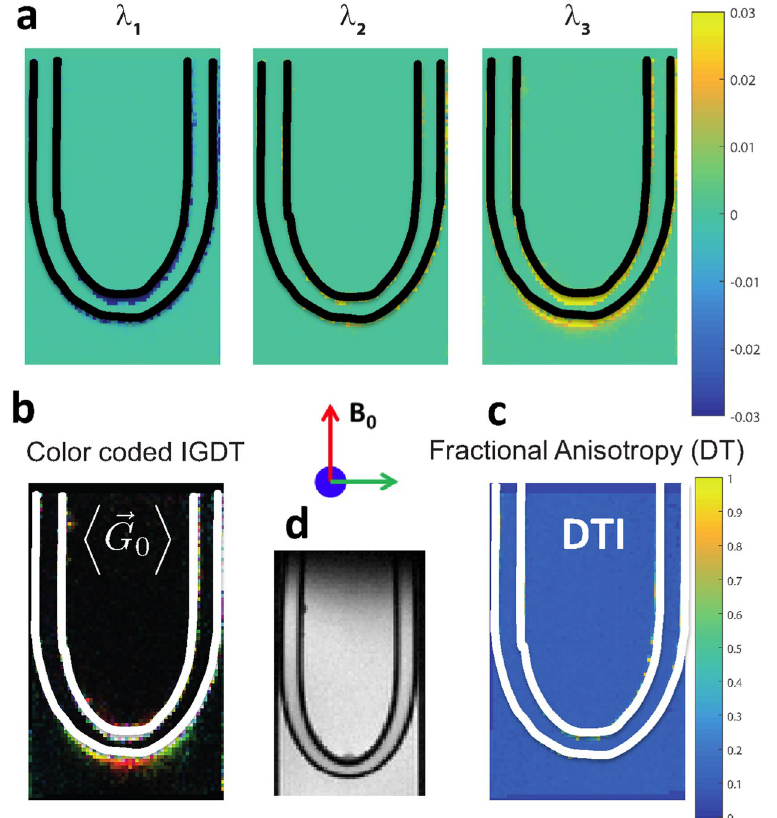
Figure 3. Mapping the average background gradient in a water phantom incorporating a rubber “U-tube”, also filled with water (see panel ( d ) for a magnetic resonance image of the analyzed object). ( a ) Images of the → G directions [1, 1, 0], [ − 1, 1, 0], [0, 1, − 1], [0, − 1, eigenvalues determined for the IGDT using six non-collinear − 1], [1, 0, − 1], [ − 1, 0, − 1]. A black mask was applied on the position occupied by the tube. Since the sample is relatively uniform most eigenvalues are null; only in the proximity of the “U” bend do spins feel the susceptibility distortions, originating the non-null eigenvalues λ 3 appearing yellow in the proximity of the bend. Other eigenvalues are indistinguishable from 0; λ 3 , the eigenvector with the largest eigenvalue, is therefore in essence a vector that defines the orientation of the average background gradient. ( b ) Color-coded orientation maps arising from this average background gradient G [red: z-axis (up-down), blue: x-axis (in-out), green: 0 y-axis (left-right)]. Parameters for these NOGSE MRI measurements were: N = 8, G = 21 G/cm, TE NOGSE = 10 ms; spatial resolution = 125 × 125 × 1000 ( μ m) 3 ; repetition and echo times TR / TE = 500/28 ms, number of averages NA = 8. ( c ) The DTI tensor determined from the sNOGSE amplitude modulation Δ β S